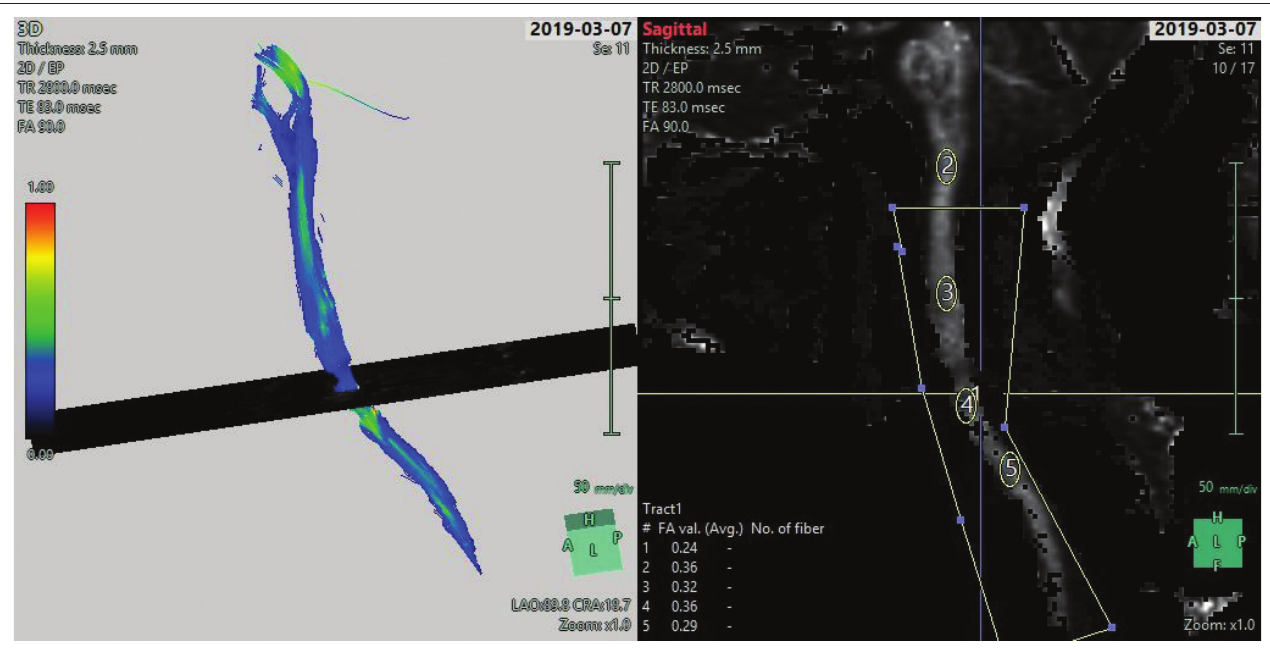
FIGURE 1 : Sagittal cervical neck tractography with four levels of interest.